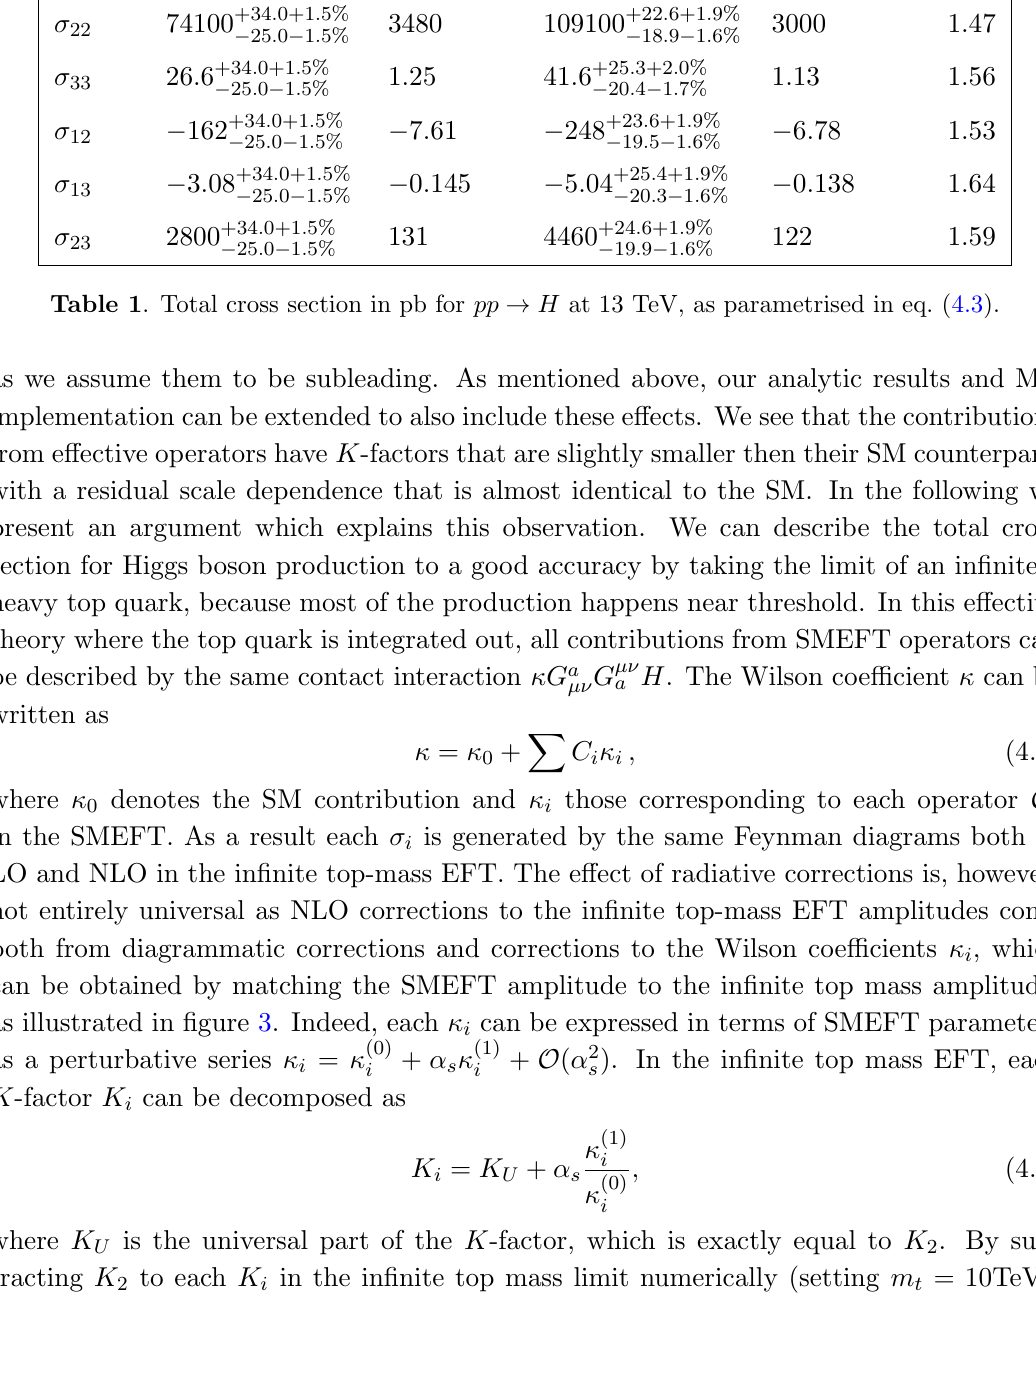
Table 1 . Total cross section in pb for pp